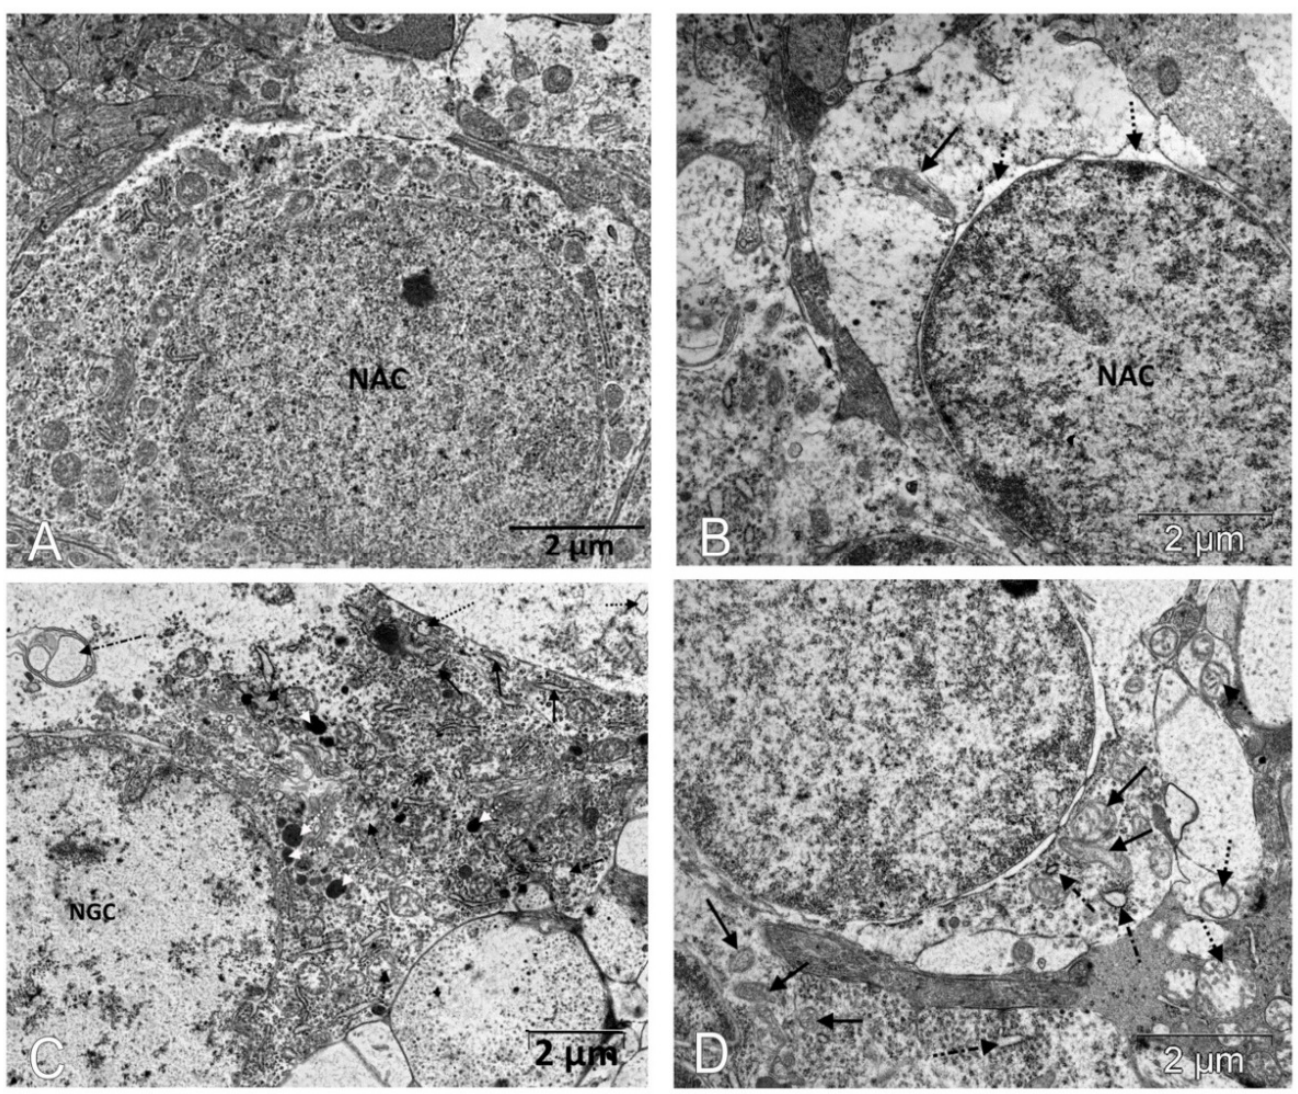
Figure 5. IQ-1S treatment improved the ultrastructure of neurons of the inner layers of the retinas in 6-month-old OXYS rats. The electron micrographs show examples of the ultrastructure of neurons of the inner layers of the retina of Wistar rats ( A ), untreated OXYS rats ( B , C ), and IQ-1S-treated OXYS rats ( D ). In the cytoplasm of the associative retinal neurons of untreated OXYS rats, there is an expansion of the perinuclear space (dashed arrows), destruction of most organelles, an increase in the size of preserved mitochondria, which have external signs of damage to the inner membrane of the cristae - local formation of electron-dense granules, tubular cristae (black arrow). ( B ). A focal destruction of organelles, a vacuolization, and a formation of multivesicular bodies (dot-dotted arrow) occur in most of the ganglion neurons; an expansion of granular ER cisterns (black arrows), an increase in the number of lysosomes (white dashed arrows), and a destruction of mitochondria are observed in the preserved parts of the cytoplasm (black dashed arrows) in the retinas of untreated OXYS rats ( C ). Treatment with IQ ‐ 1S leads to a greater preservation of organelles, including mitochondria (black arrows), but some of them increase in size; swelling and destruction of cristae are observed in them (dashed arrow). The cisterns of the granular ER are fragmented and expand, but do not lose their connection with the ribosomes (dot ‐ dotted arrow) ( D ). Table 2. Effects of IQ ‐ 1S on the specific areas of organelles in the cytoplasm of associative and gan ‐ glion neurons (according to electron micrographs).